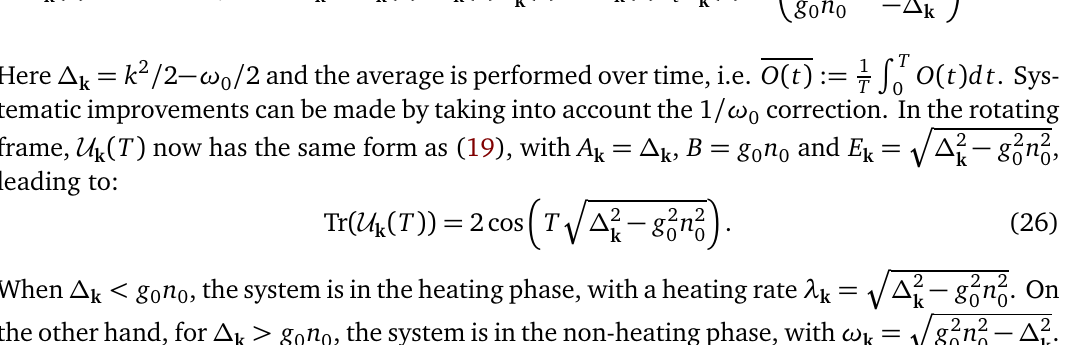
( T )) | with g n T = 1. This determines λ k 0 0 ( T )) | < 2 (non-heating phase). for | Tr ( U k k ( T )) | = k